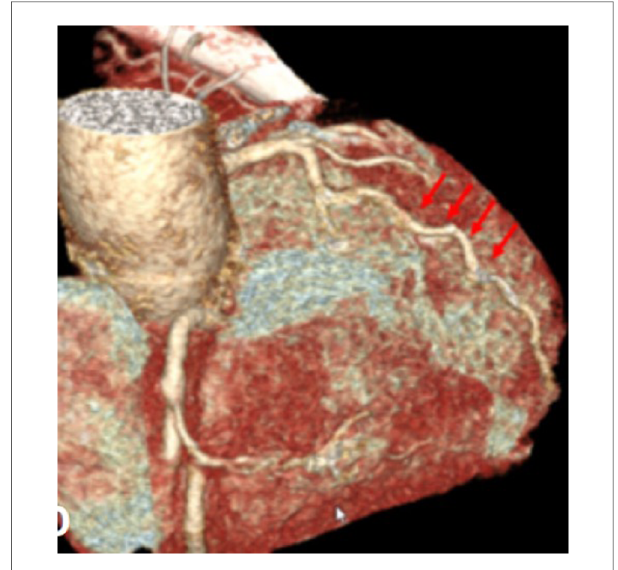
FIGURE 5 Postoperative CT scan showing the patent left anterior descending artery (red